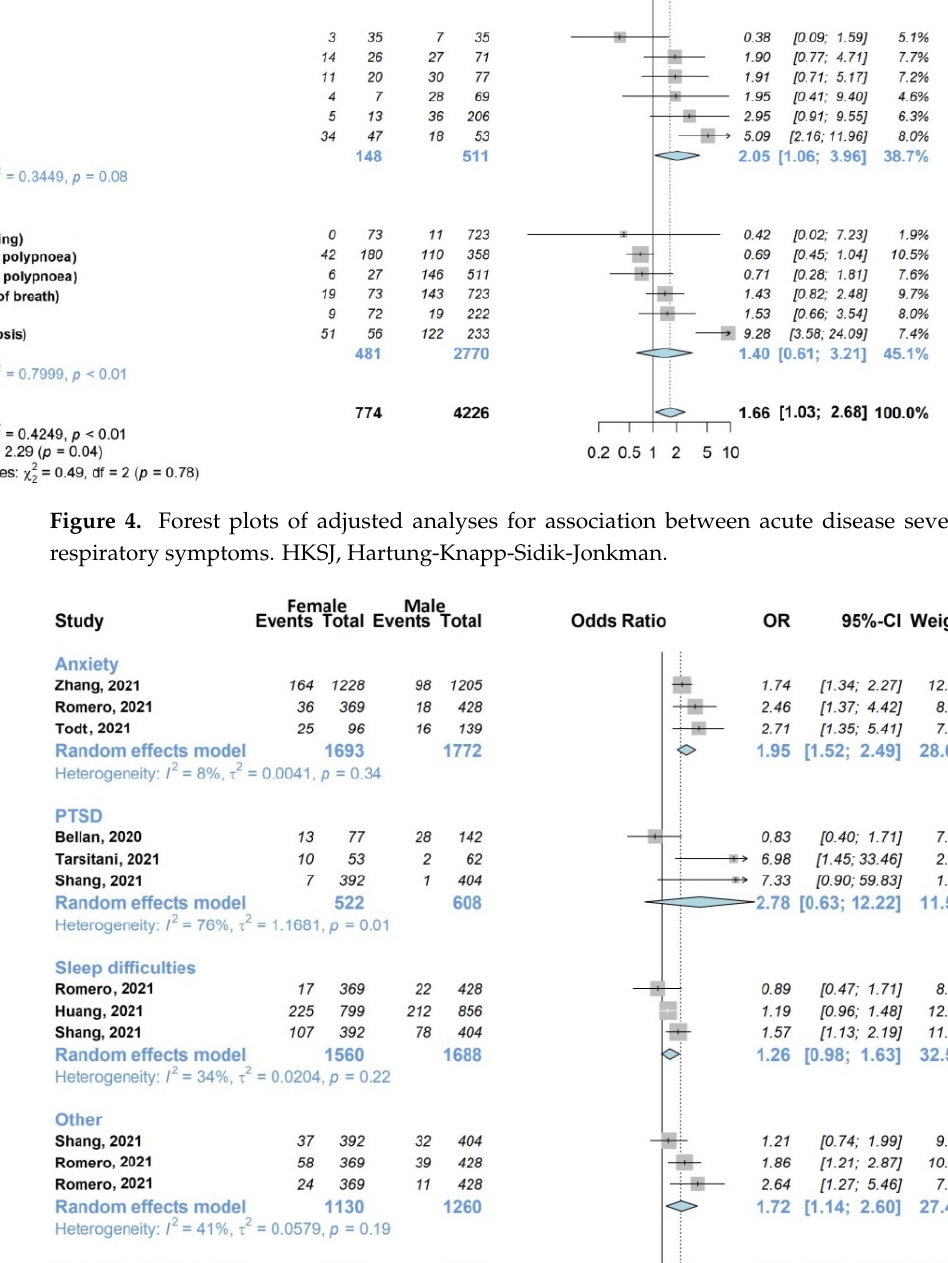
Figure 4. Forest plots of adjusted analyses for association between acute disease severity and respiratory symptoms. HKSJ, Hartung-Knapp-Sidik-Jonkman.